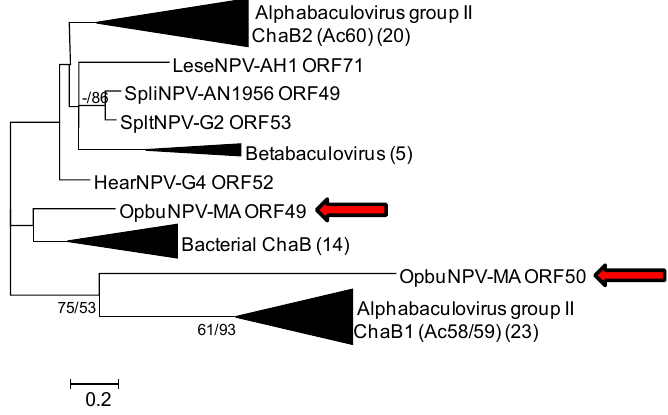
Figure 6. Phylogenetic inference from aligned viral and bacterial cation transporter (ChaB) homologs. An ML phylogram inferred from the alignment of ChaB amino acid sequences is shown with bootstrap values (>50%) at interior branches for ME and ML analysis (ME/ML) where they occur. Branches for ChaB sequences encoded by bacteria, betabaculoviruses, alphabaculovirus chaB1 ( ac58/59 ) genes, and alphabaculovirus chaB2 ( ac60 ) genes have been collapsed, and the numbers of taxa in each of these nodes are indicated in parentheses. OpbuNPV sequences are indicated with red arrows. The virus and bacterial taxa and their accession numbers are as listed in Table S1.